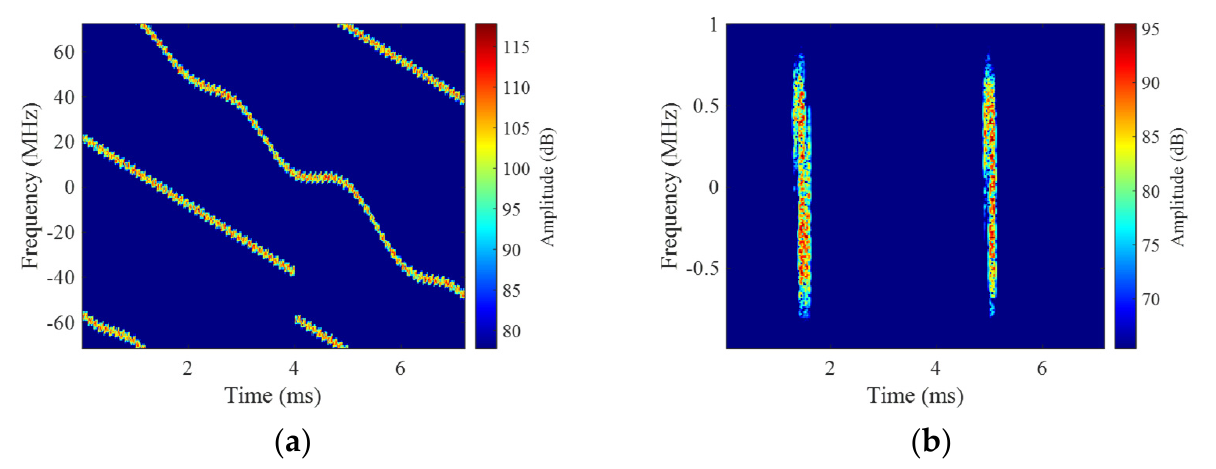
Figure 3. TFS diagrams of the WBI after ( a ) down-converting and ( b ) low-pass filtering with a pass frequency of 0.5 MHz and a stop frequency of 1 MHz.